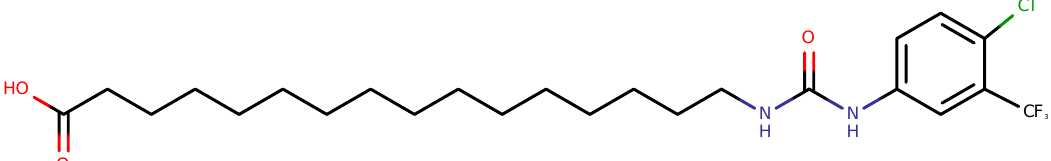
Figure 1. Structure of the ω-3 polyunsaturated fatty acid derivative 16-(4′-chloro-3′- trifluorophenyl)carbamoylamino]hexadecanoic acid (ClFPh-CHA).